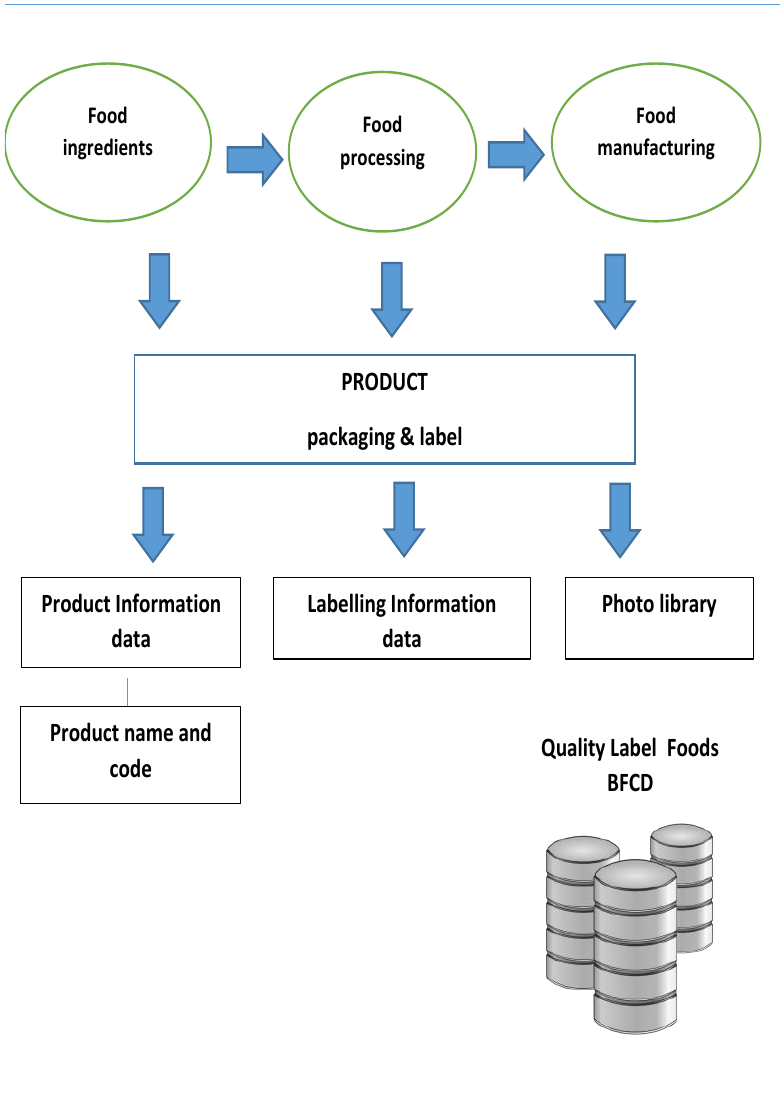
Figure 5. Flow-diagram presenting methodology for and the design and development of a branded food composition database (BFCD) for “quality label” foods.